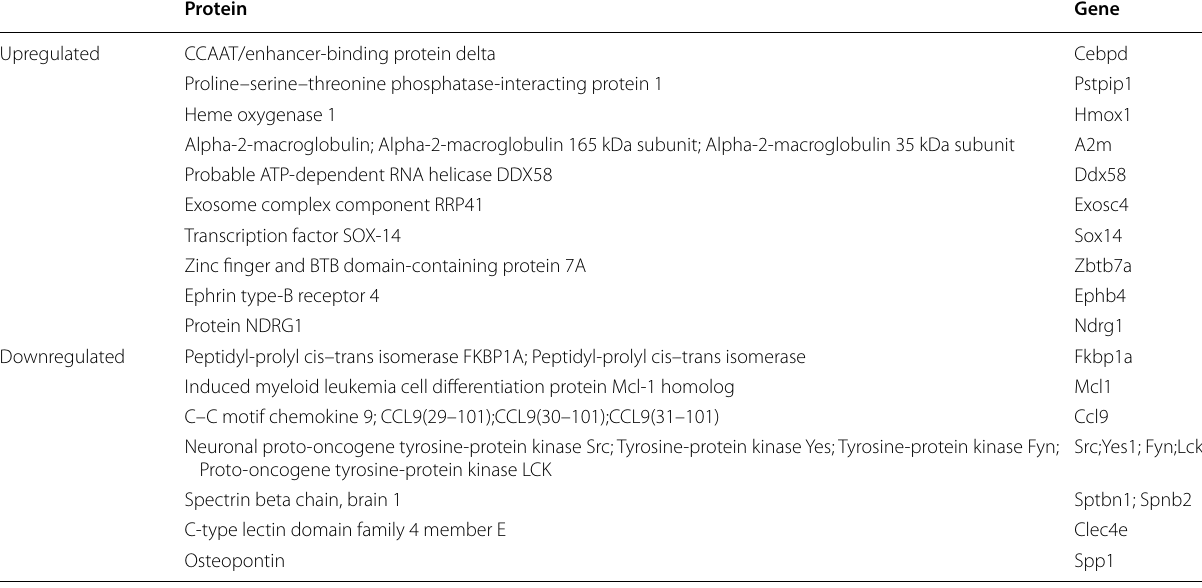
Table 2 Immune system process related proteins through GO annotation